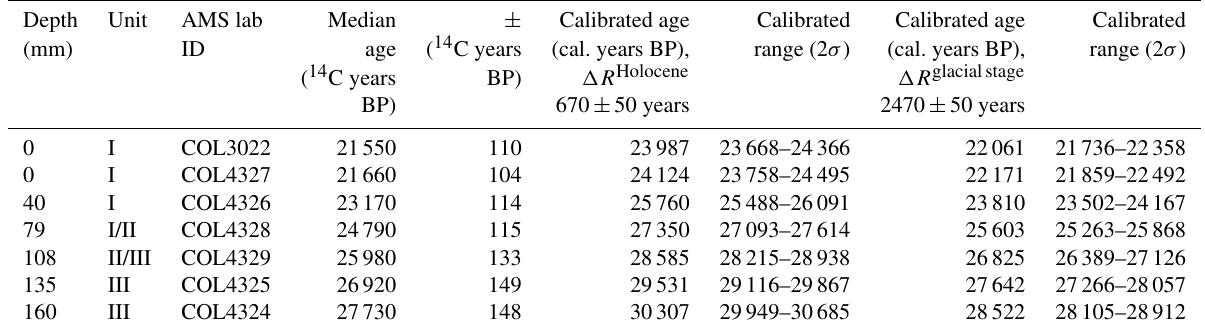
Table 1. Radiocarbon dates and calibrated ages. All 14 C analyses were performed on bulk samples at CologneAMS, Germany. COL3022 was previously published (Berg et al., 2019). All calibrations to calendar ages used MARINE20 (Heaton et al., 2020). To explore the likely range of impacts of sea ice on our 14 C calibrations, we first apply the nearest Holocene (cid:49)R of 670 ± 50 years (Björck et al., 1991), which assumes low or absent sea ice sampled by WMM7 as suggested for the last glacial stage, generated by adding 1800 years of additional ocean 14 C depletion as suggested by Heaton et al. (2020,